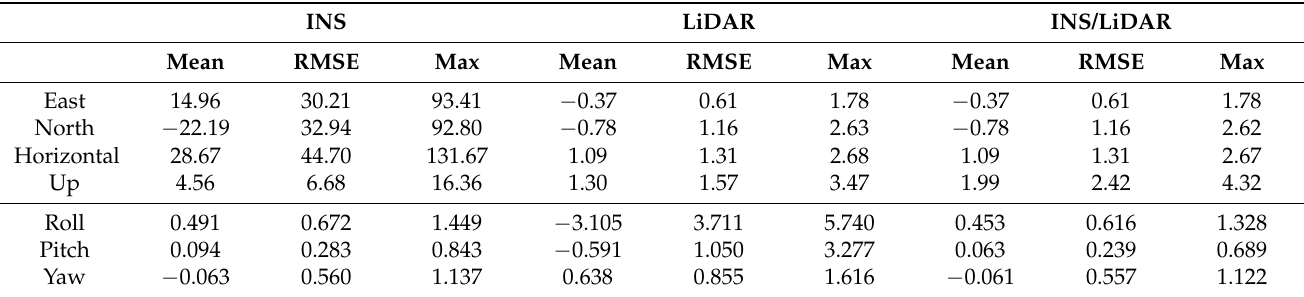
Table A17. D-87—position (m) and attitude (deg) error